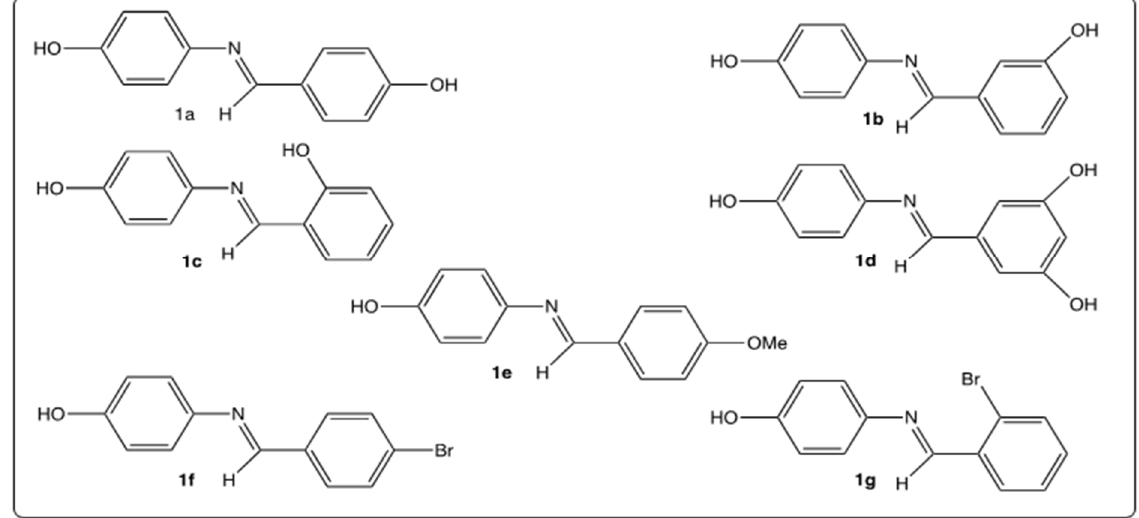
Figure 2. Structures of AZA-ST 1a–g [15] .